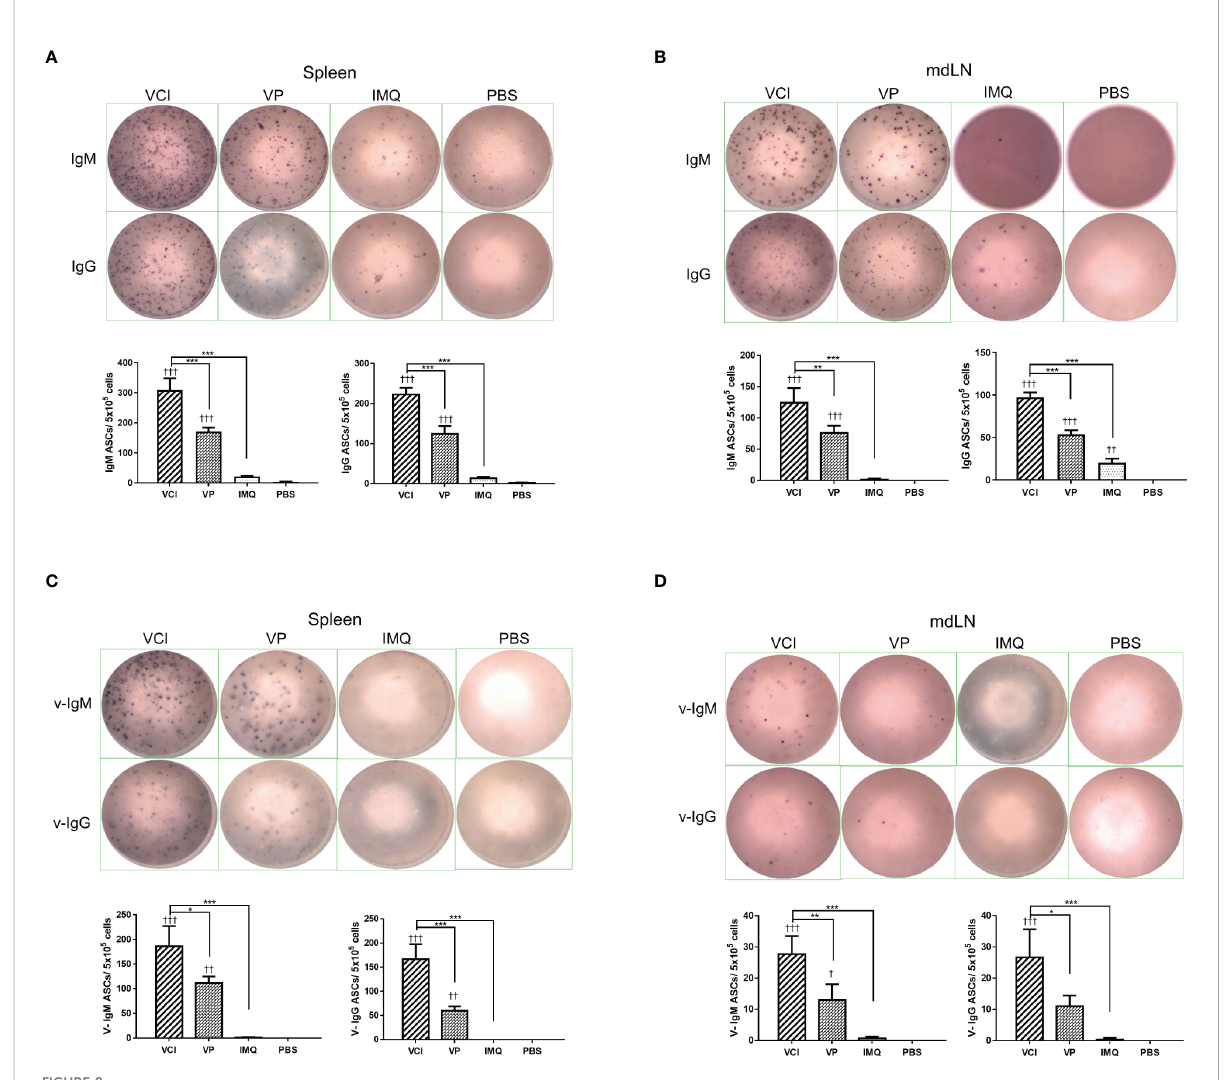
FIGURE 8 Antibody responses in spleen and mdLN. Mice received intraperitoneal administration of VCI (IMQ 50 µg + VP 10 µg), IMQ (50 µg) or VP (10 µg) or PBS for 3 days, and then were challenged with 10×LD50 of H1N1/415742Md virus. At 3 days after virus challenge, single cells were prepared from spleens and mdLNs. ELISPOT detection of total IgM, IgG, viral speci fi c IgM and viral speci fi c IgG. (A) Total IgM, IgG secreting cells from spleen; (B) Total IgM, IgG spots from mdLN. (C) Viral speci fi c IgM, IgG secreting cells from spleen; (D) Viral speci fi c IgM, IgG secreting cells from mdLN. Data presented are mean of three different experiments for each type of the antibody secreting cells. n = 3. † p < 0.05; †† p < 0.01; ††† p < 0.001 (compared with PBS group). *p < 0.05; **p < 0.01; ***p < 0.001 (comparing between VCI group with other treatment